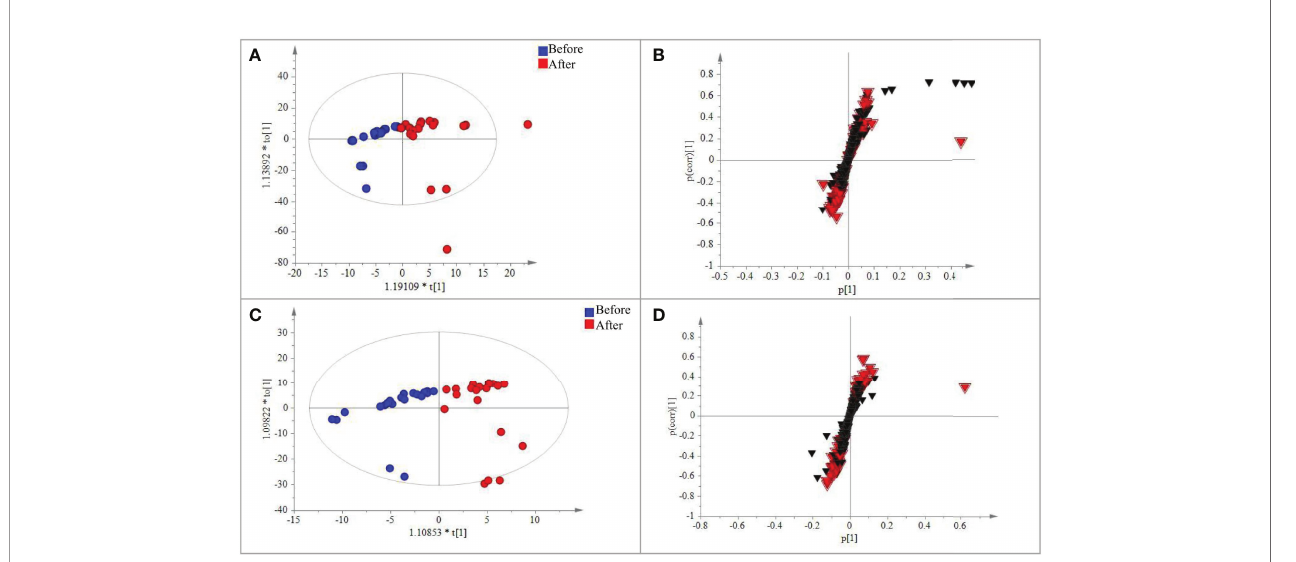
FIGURE 3 | PLS-DA analysis of the metabolic data detected in the positive and negative modes, respectively. (A) Plot of the scores from the PLS-DA of metabolic data for CRC patients before and after treatment in the positive negative mode. (B) Loading plot from the PLS-DA analysis of metabolic data for CRC patients before and after treatment in the positive – negative mode. (C) Plot of the scores from the PLS-DA of metabolic data for CRC patients before and after treatment in the positive – negative mode. (D) Loading plot from the PLS-DA analysis of metabolic data for CRC patients before and after treatment in the positive negative mode. The circle dots represent the test serum samples, and metabolites are shown as triangles. Metabolites labeled with the red triangle played important roles for the